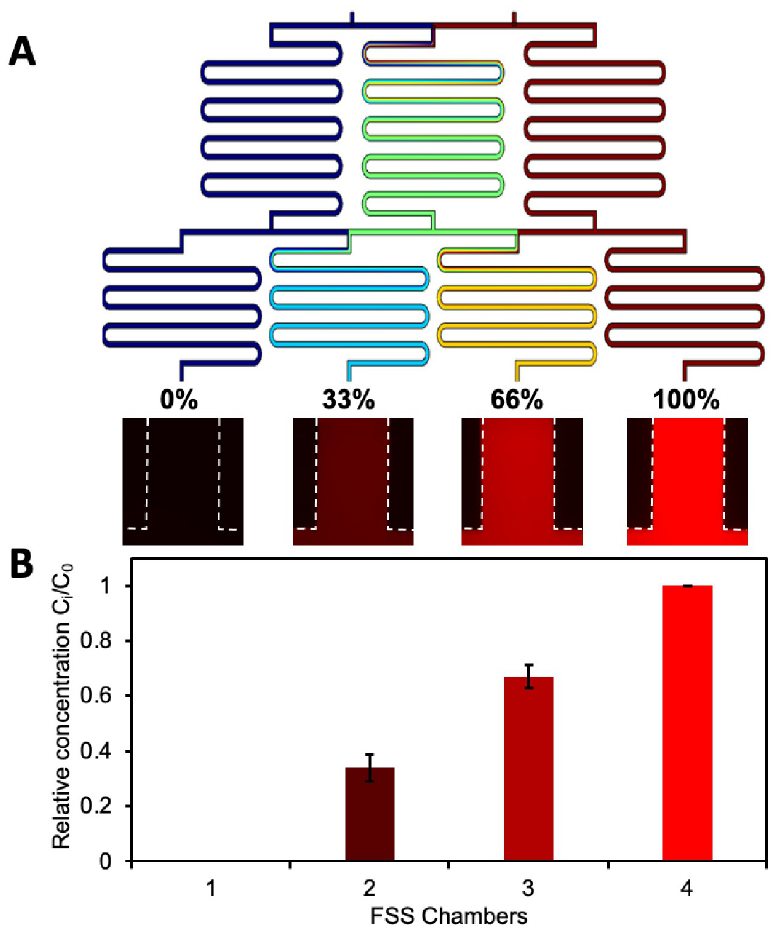
Fig 2. Characterization of concentration gradient formation. (A) Computational fluid dynamic (CFD) simulation of the concentration gradient generator (CGG) and (B) experimentally obtained fluorescent images of the resulting concentration gradient. Graph showing normalized concentrations of resazurin in four FSS chambers. FSS chambers 1 and 4 were set as 0 and 100 relative concentrations, and the mean relative concentration ± standard deviation of FSS chamber 2 and 3 are